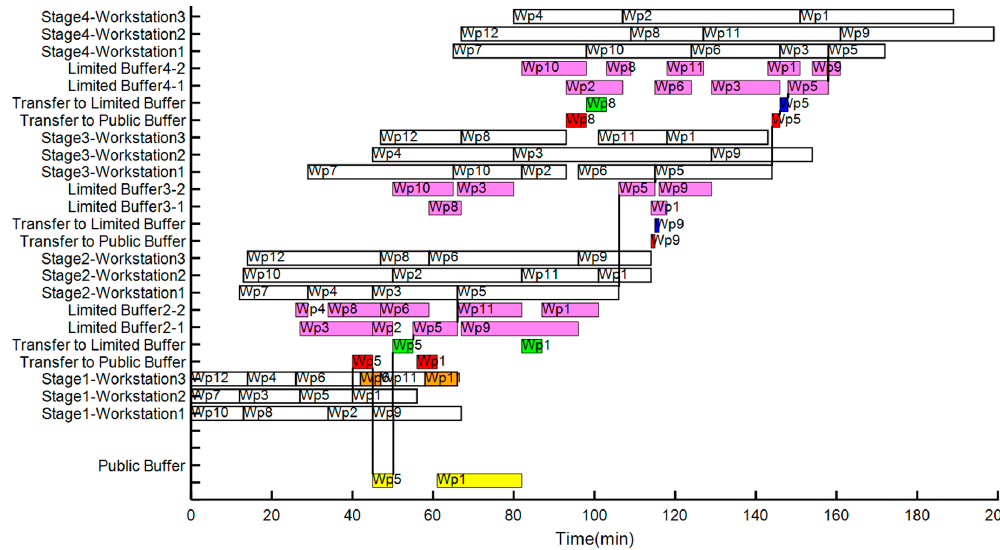
Figure 4. Gantt chart of scheme 3 scheduling result.